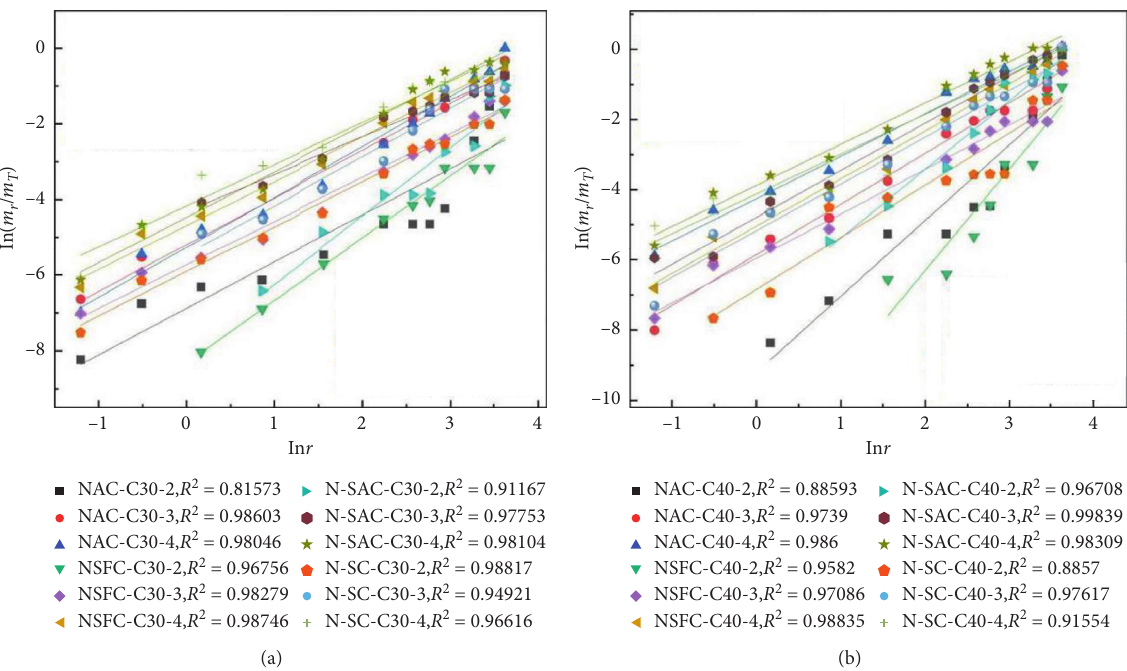
Figure 16: ln ( m m ) − ln r curves. (a) C30 configuration strength. (b) C40 configuration r / T Figure 16 is the typical ln ( m r / m T ) − ln r relationship curve of each group of concrete under C30 and C40 con- figuration strengths. It can be seen from Figure 16 that the slope of the fitting curve between coal gangue concrete and ordinary concrete gradually decreases with the increase of impact pressure when the strength is C30 and C40. According to Figure 14, it can be found that the degree of fragmentation of the test piece is gradually increasing, and the proportion of small particle size fragments continues to increase, indicating that the mass distribution of the test piece continues to move to the small particle size end with the increase of impact pressure.